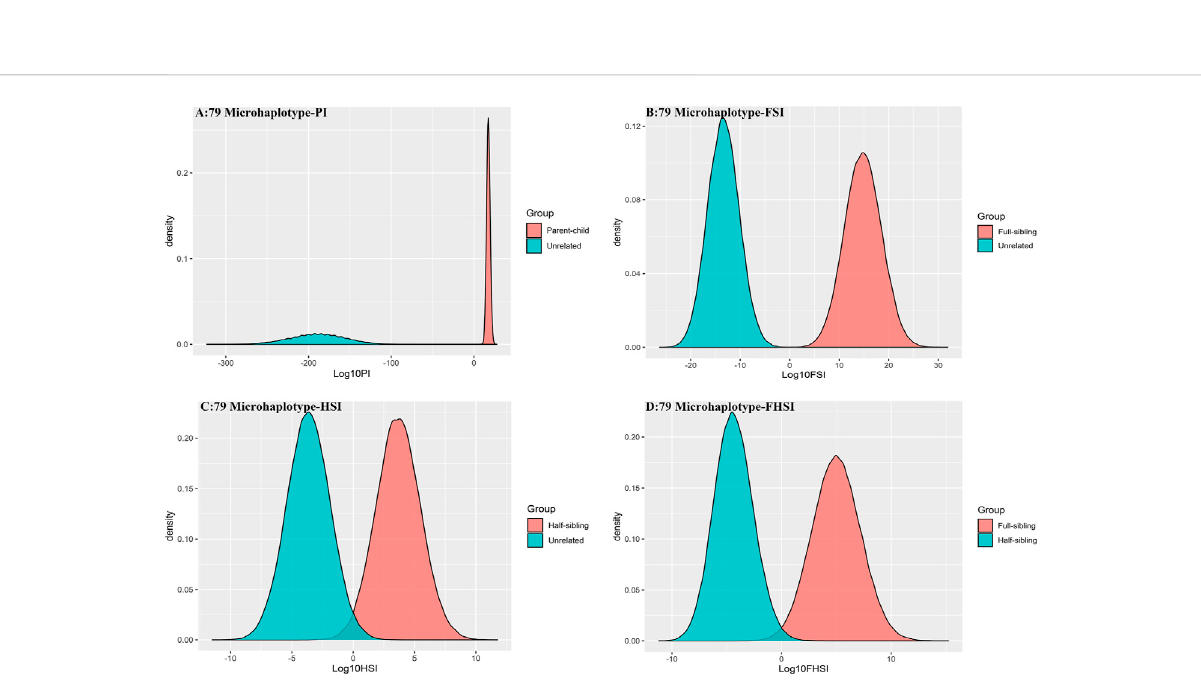
FIGURE 4 The distributions of Log 10 of PI, FSI, HSI and FHSI based on the data of 79 microhaplotype loci. (A) PI; (B) FSI; (C) HSI; (D)